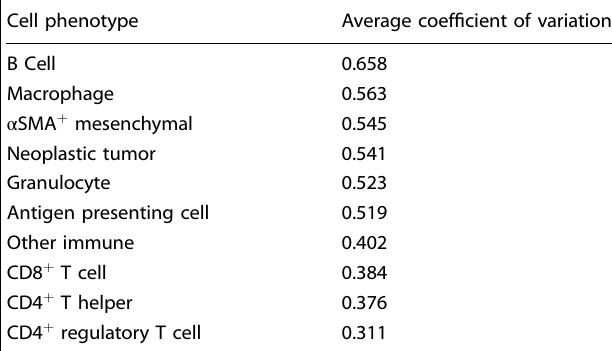
Table 3. Coef fi cient of variation. Cell